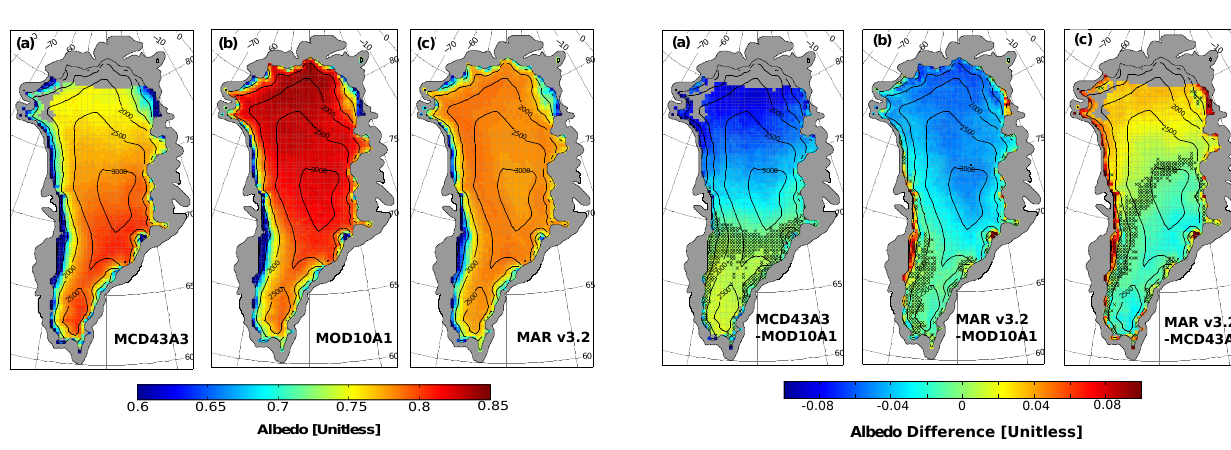
Figure 2. Mean 2000–2013 JJA albedo (unitless) for (a) the Figure 3. Mean difference in JJA albedo (unitless) for the 2000– MCD43A3 BSA SW product (on the MAR grid) (b) MOD10A1 2013 period: (a) MCD43A3 BSA SW minus MOD10A1 (b) MAR product (on the MAR grid), and (c) MAR v3.2 clear-sky albedo. v3.2 clear-sky minus MOD10A1, and (c) MAR v3.2 clear-sky mi- Only good quality data MODIS data are used here. nus MCD43A3. In each case, only coincident data for each of the two data sets being compared is used. MAR grid boxes where the difference is not statistically significant at the 95% confidence level Table 3. Mean 2000–2012 JJA GrIS albedo, for MOD10A1, are marked with a grey MCD43A3 BSA SW, and MAR clear-sky albedo, averaged within the mass balance areas shown in Fig. 1 and Table 2. Only good qual- ity MODIS data are used here. All data have been averaged over the same 16-day period of the MCD43A3 product. Only periods when coincident data for all data sets were available have been included. MCD43A3 MAR Locations